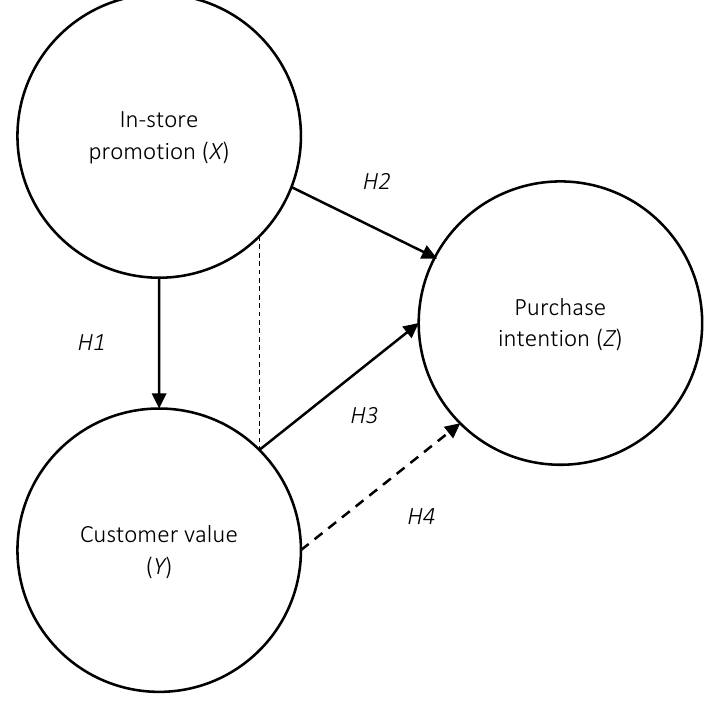
Figure 1. Research